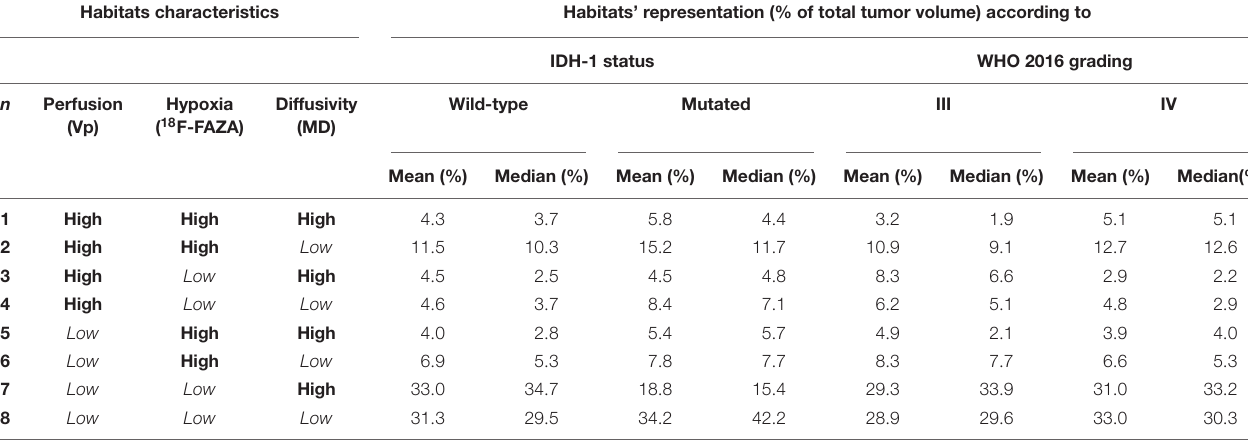
TABLE 5 | Mean and median representation of the eight different habitats according to IDH-1 status and WHO 2016 grade. Habitats characteristics Habitats’ representation (% of total tumor volume) according to